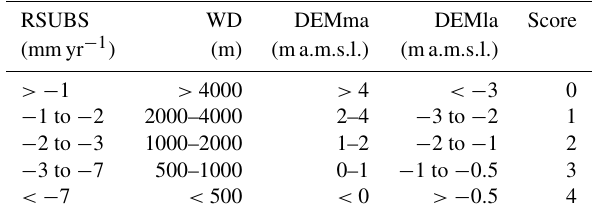
Table 1. Range of scores and weightings assigned to each classified thematic layer.